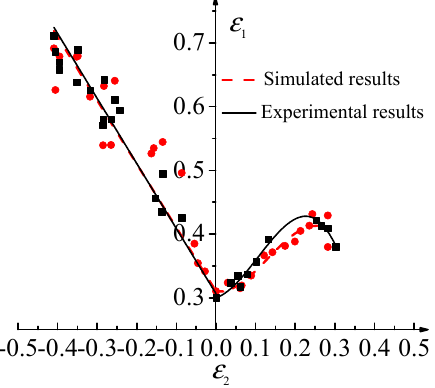
Figure 11. Comparison of FLD of TA1 between simulated and experimental results.